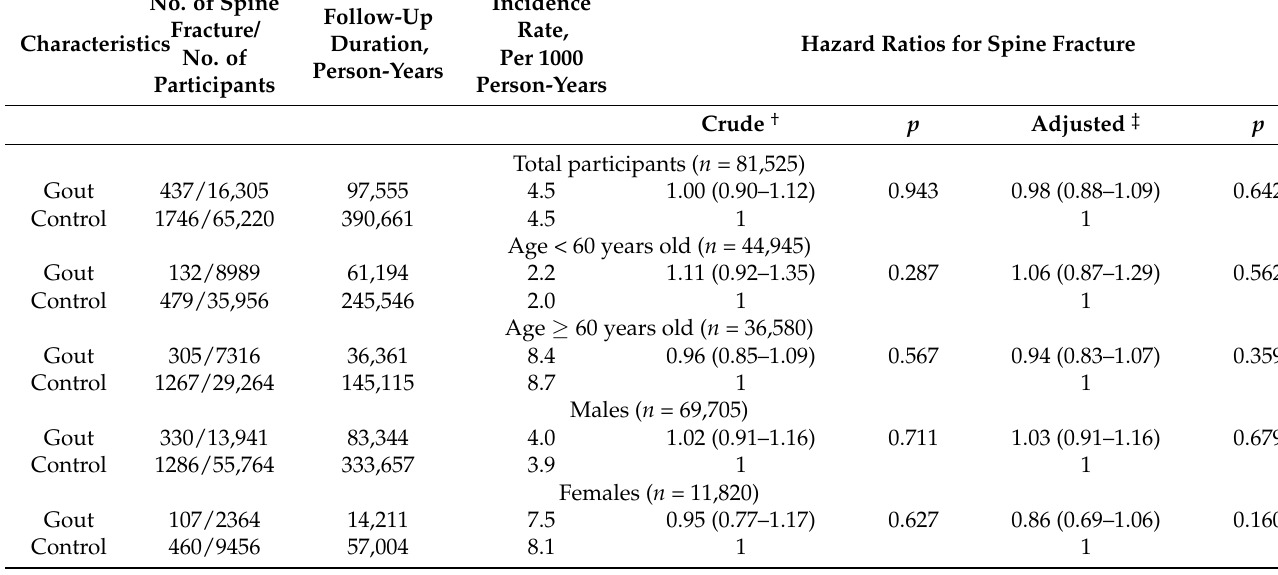
Table 5. Hazard ratio (95% confidence interval) for spine fracture in the gout and control groups with subgroup analyses according to age and